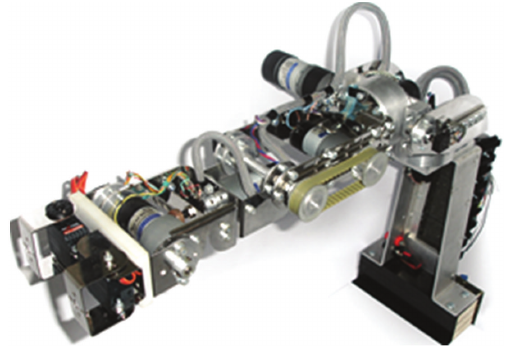
Figure 5: The first prototype robotic arm developed by our team. It is capable of moving at angular speed comparable to the natural motion of a human operator’s arm. It comprises 6 DC motors (one for each DOF) and 2 servomotors for the